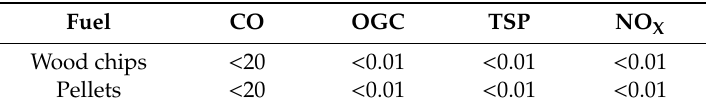
Table 4. Direct emissions (mg) to air per MJ of overall energy output (heat and electricity). OGC = organic gaseous compounds, TSP = total suspended particle, NOX = nitrogen oxides. Maximum values shown in the table were used in the Life Cycle